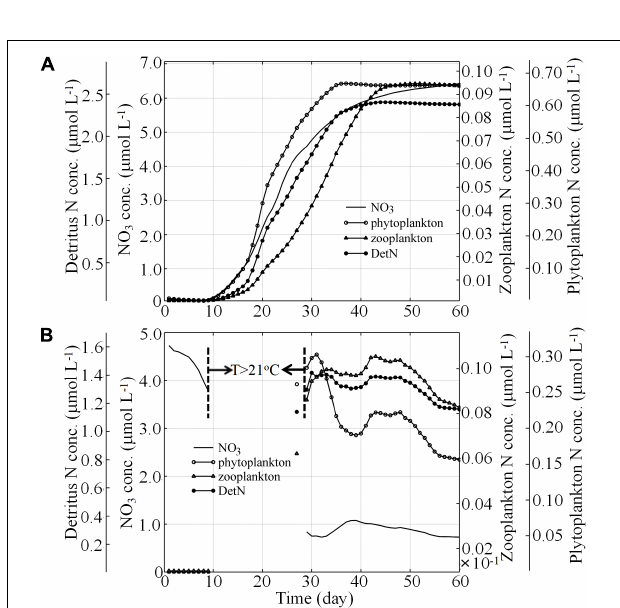
FIGURE 11 | Time series of the average N , P , Z , and D (A) in the nearshore waters and (B) in the bottom waters between the 50 and 100 m isobaths from Shanwei to